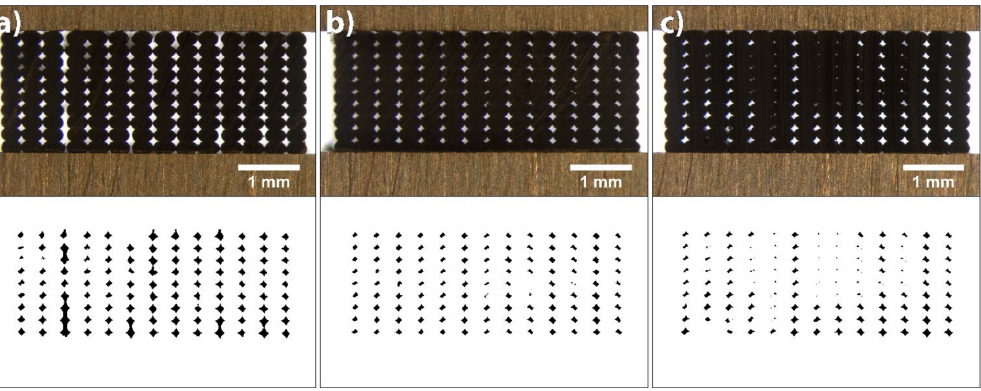
Figure 7. Images of cross-sectional area of 3D printed test samples from TPU and binary images belonging to them at extrusion multipliers: ( a ) 1.1, ( b ) 1.15 and ( c ) 1.2.